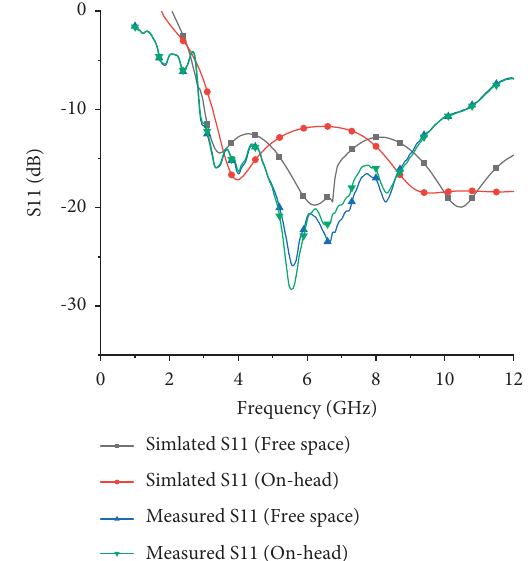
Figure 11: Simulates and measures the reflective coefficient of the proposed antenna in free space and on the human